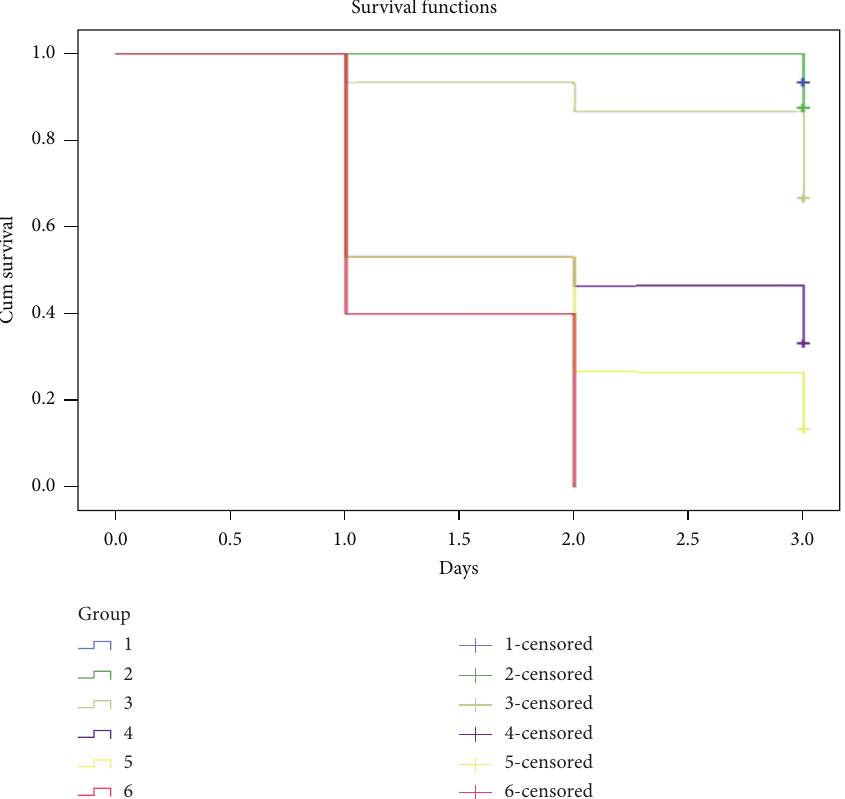
Figure 3: Acute toxicity test of crude extract on the survival rate of adult Javanese medaka treated with different concentrations of the crude extract (62.5–1000mg/L). The percentage of survival rate is shown versus concentration of crude extract. ∗ P < 0 . 01 represented significant different values of the control group and group exposed to crude extract. The values represent mean ± SD from three ( n � 3) independent